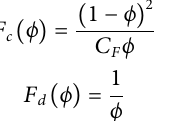
( Figure 2 ). There are a nonlinear relationship and a linear relationship shown in Figure 2 . The non-linear and linear ones are derived from F c ( φ ) and F d ( φ ), respectively.